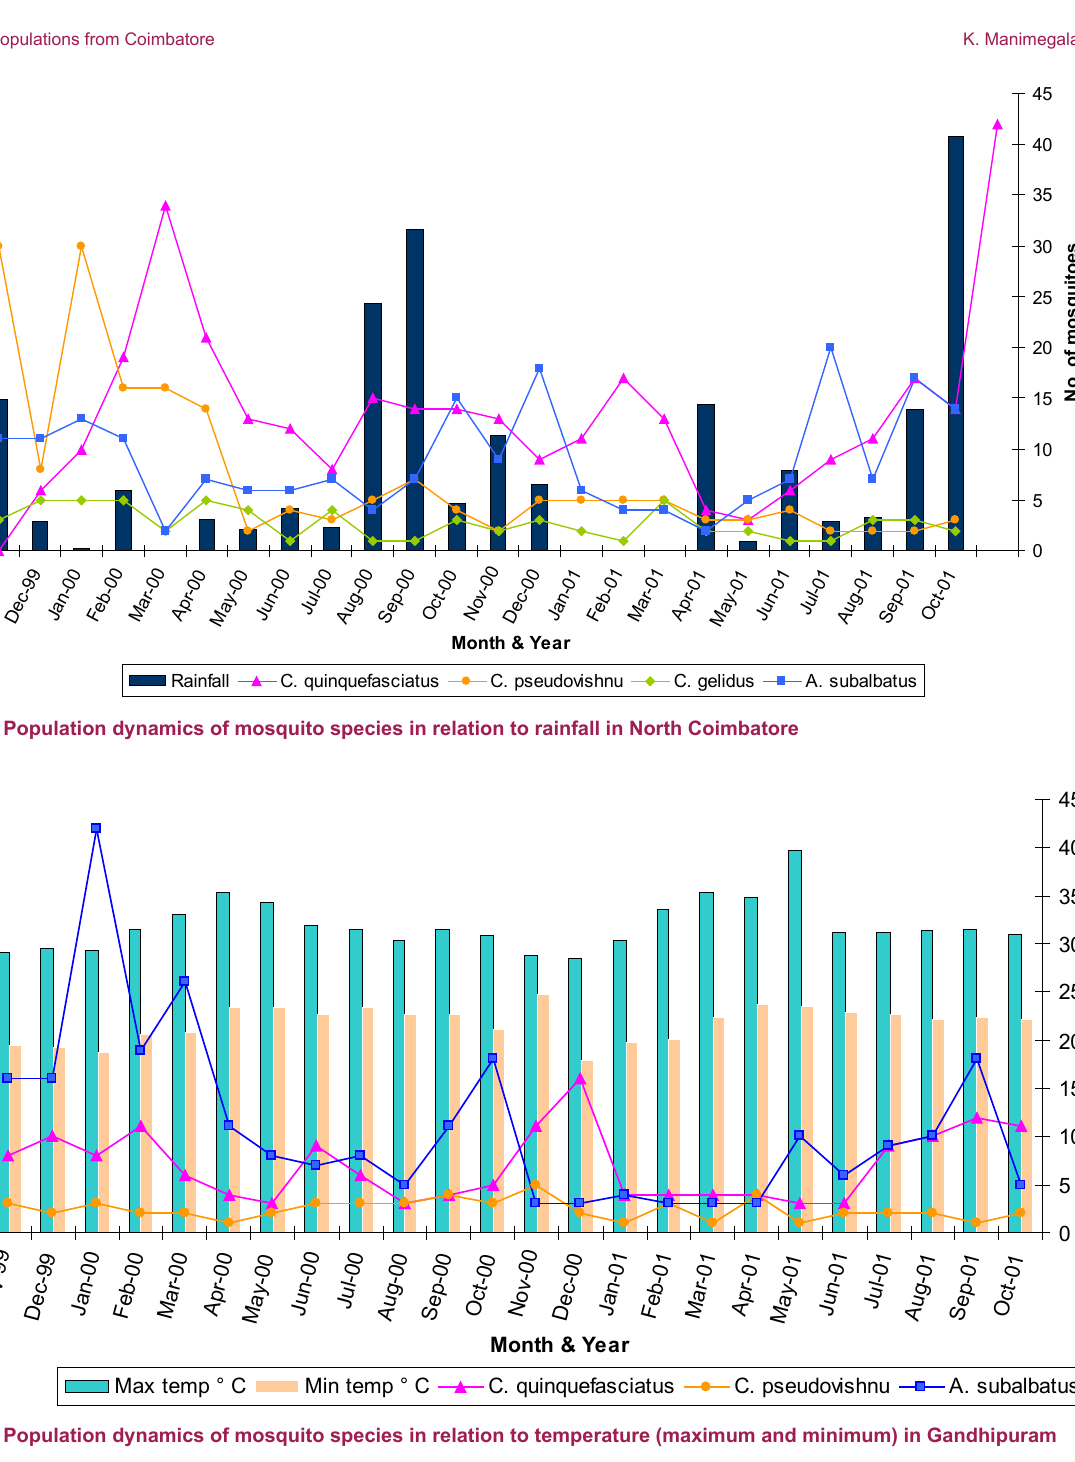
Figure 4. Population dynamics of mosquito species in relation to temperature (maximum and minimum) in POPULATION DYANMICS OF MOSQUITO SPECIES IN RELATION TO TEMPERATURE IN GANDHIPURAM